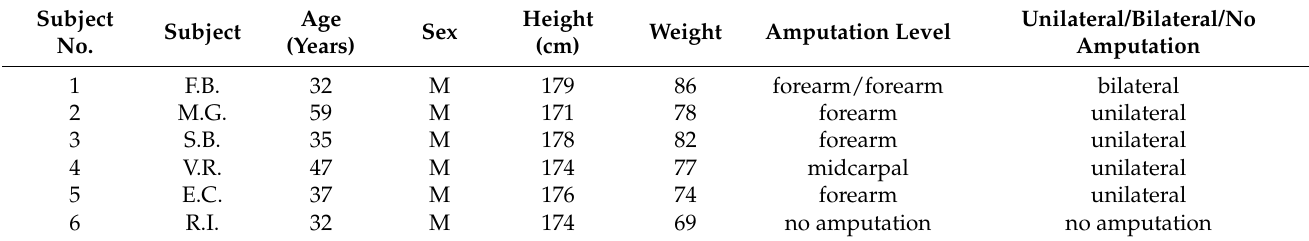
Table 2. Characteristics of the test subjects.